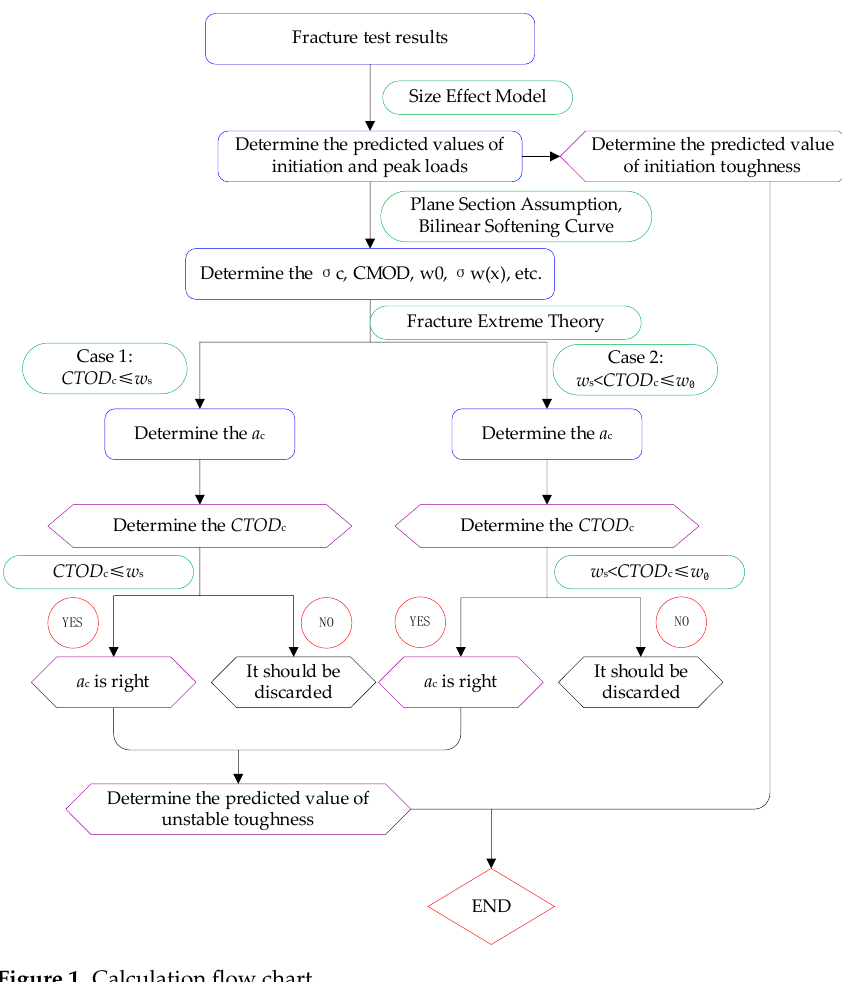
Figure 1. Calculation flow chart.